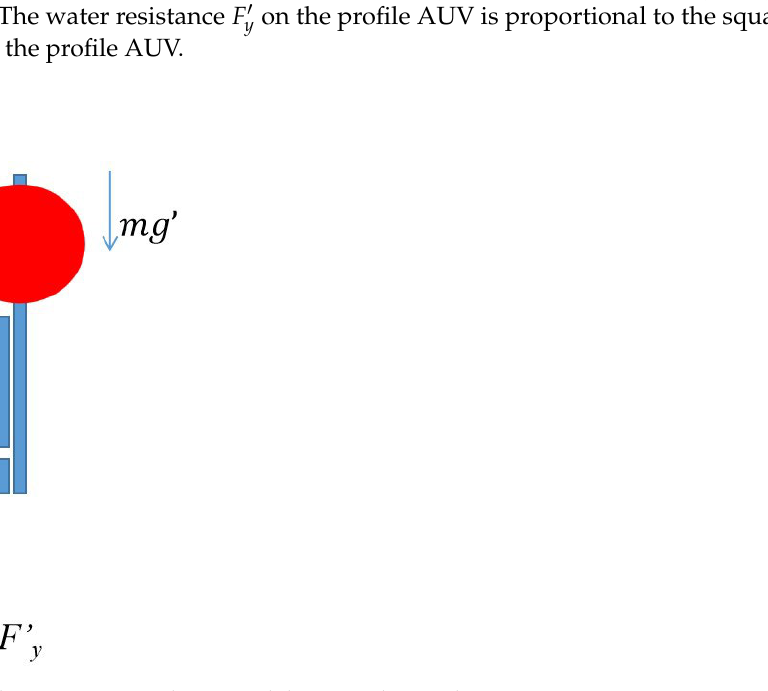
Figure 22. Different depth flow speed.